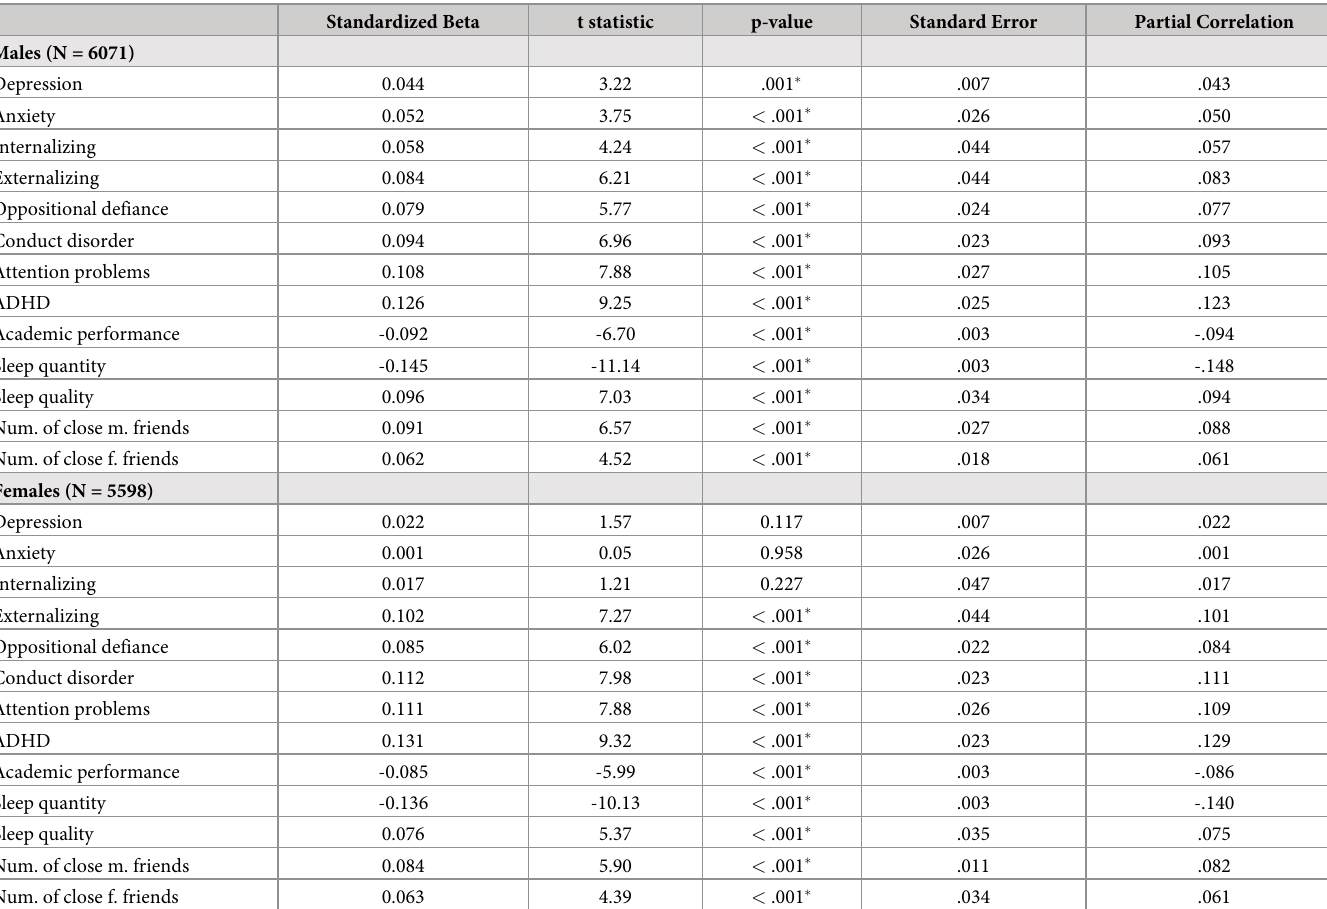
Table 5. Outcome measures regressed on weekend total screen time for Part 2, controlling for SES and race/ethnicity, separated by